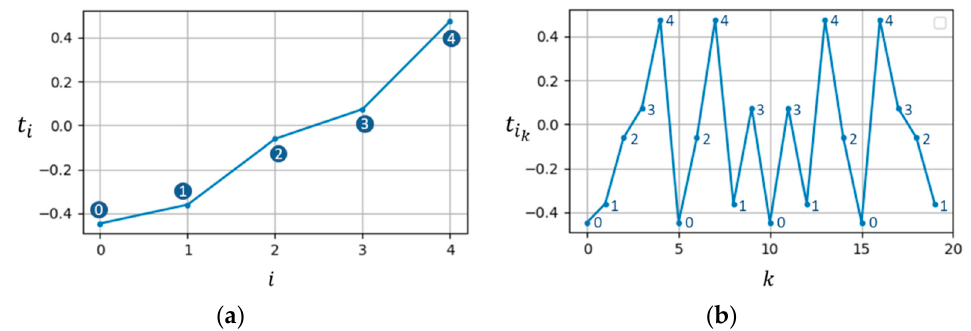
Figure 8. ( a ) Selected t i values (normalized by τ ) for N = 5 and ( b ) the waveform sequence generated using the Eulerian circuit.